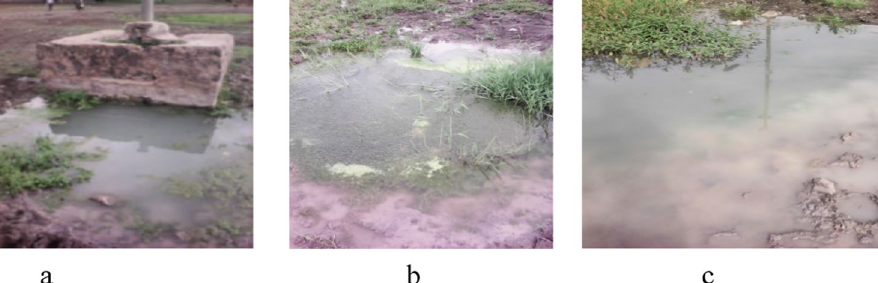
Fig. 1 Map of the study area, 2020 Fig. 2 A water sample from a Yeduha, b Mozegne, and c Mergech sample site,